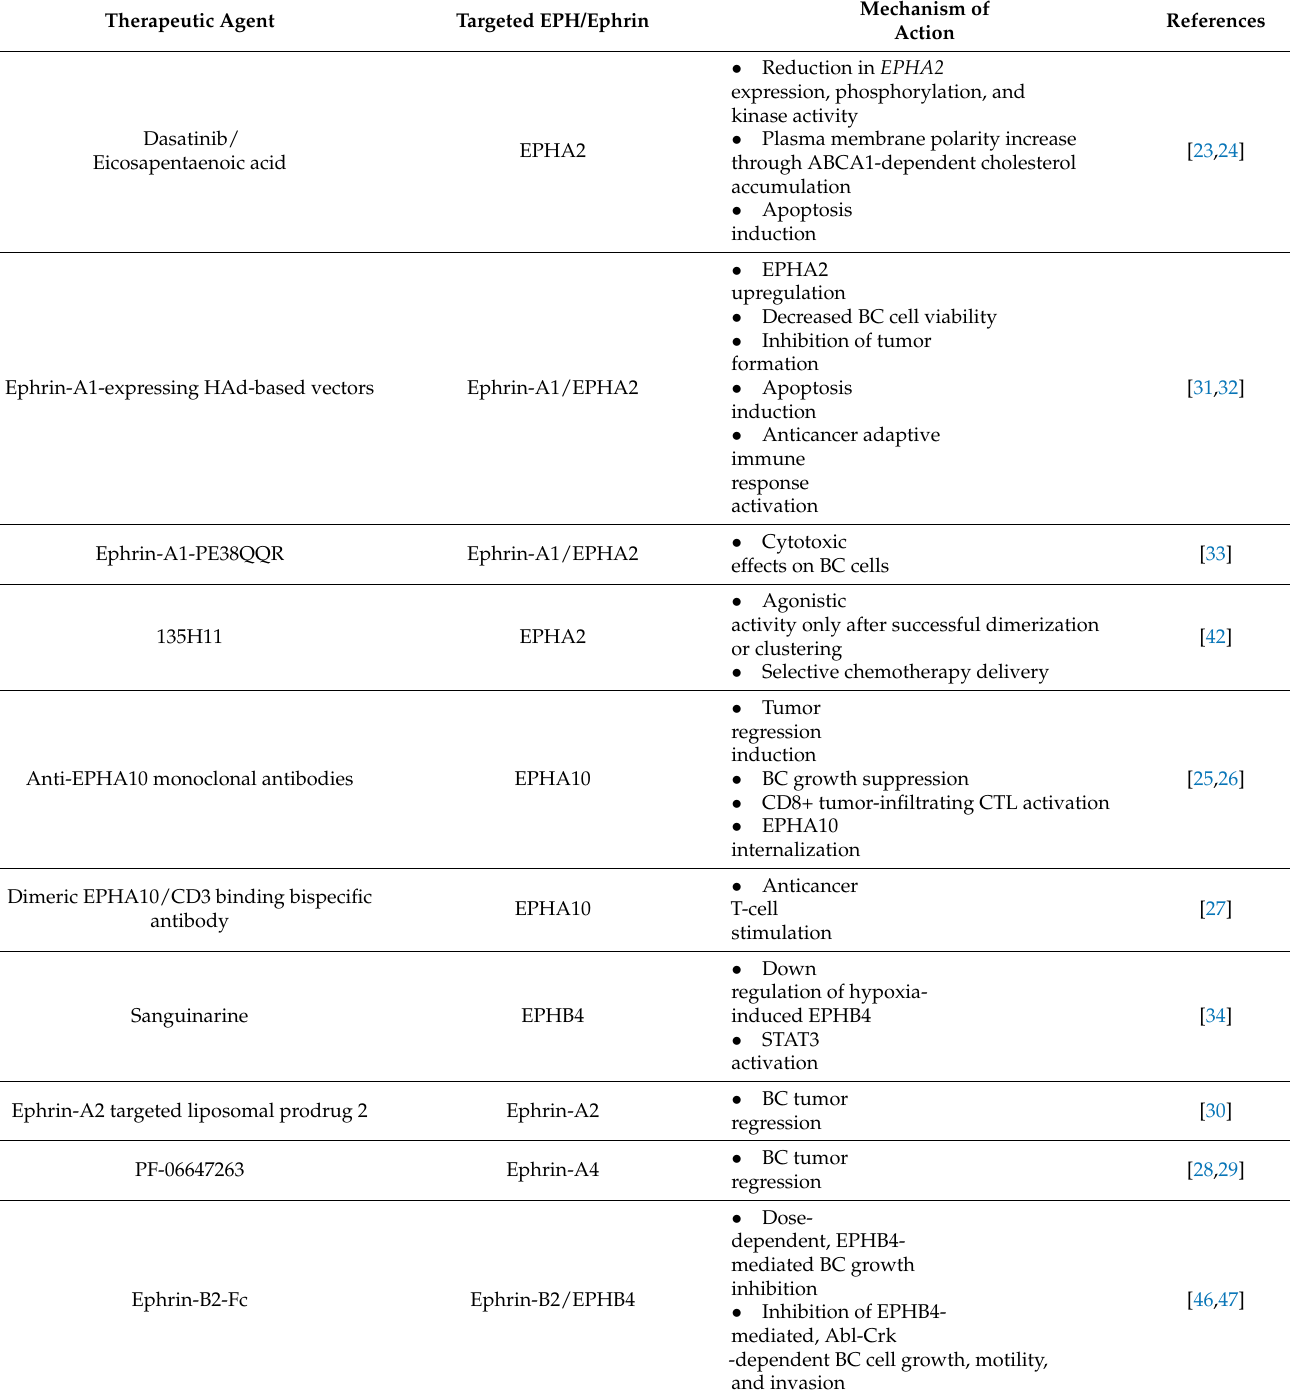
Table 2. Effects of different therapeutic agents on the EPH/ephrin system in